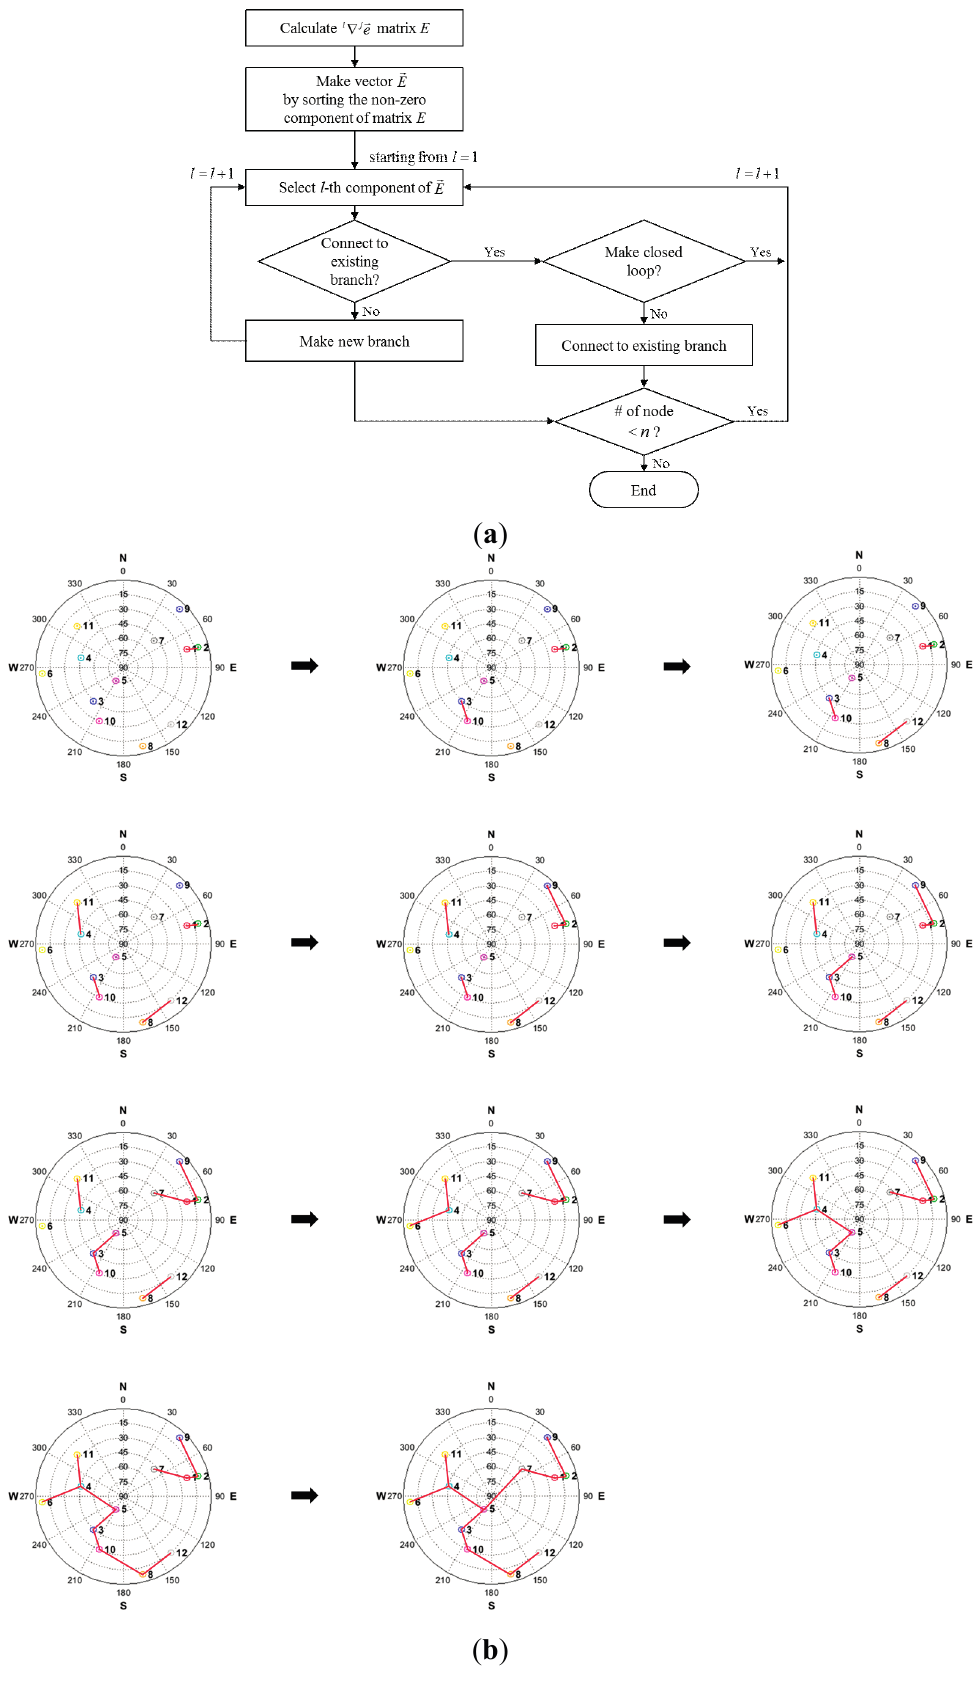
Figure 3. ( a ) Block diagram of satellite pairing process (above); ( b ) sequence of satellite pairing process